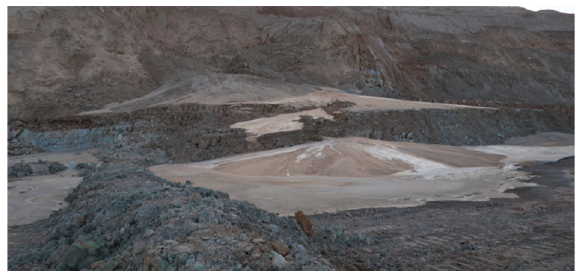
Fig. 9 Weak outcrop at the foot of the